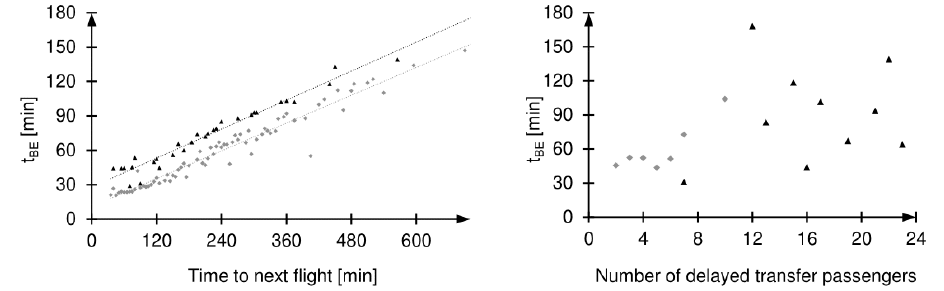
Figure 7. Applicability of delaying connecting flights ( DELAY ) as delay cost compensation strategy in a high total operating cost scenario. The time until which the compensation is worthwhile t BE increases with increasing allowed waiting time until the next possible flight. Widebodies are indicated by black triangles, narrowbodies by grey dots. Due to high compensation costs, which do not depend on the number of passengers, but on the number of delayed aircraft, the number of connecting passengers seems to have no direct influence on the productivity of this strategy.